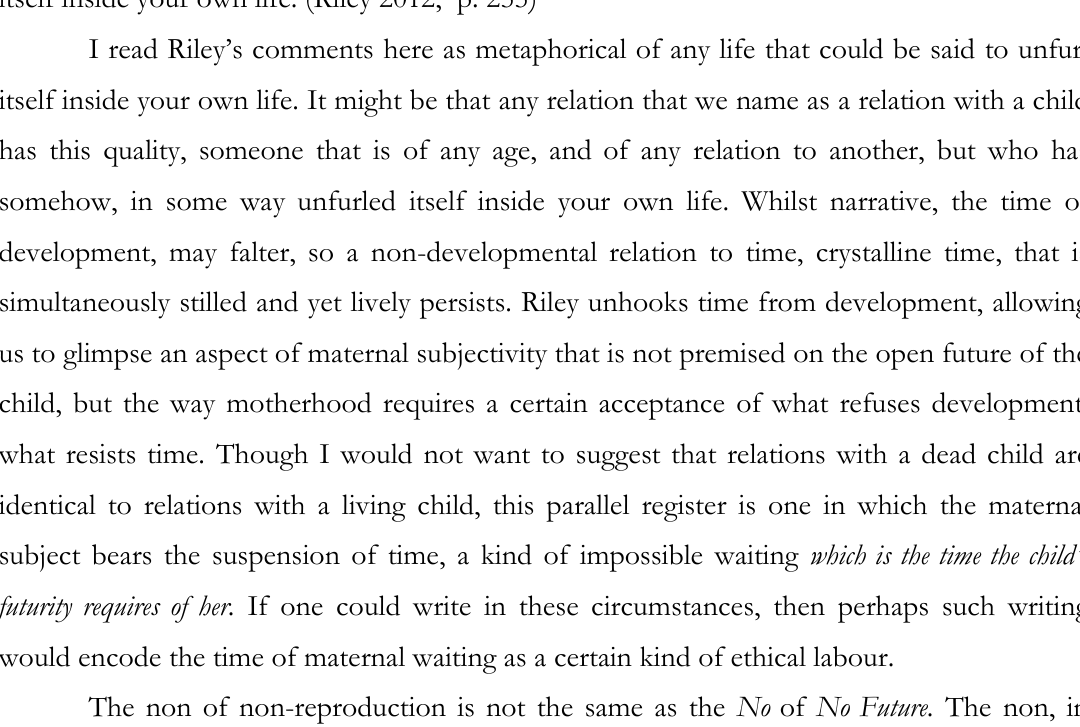
Lisa Baraitser, Time and Again: Repetition, Maternity and the Non-Reproductive Studies in the Maternal , 6(1), 2014,